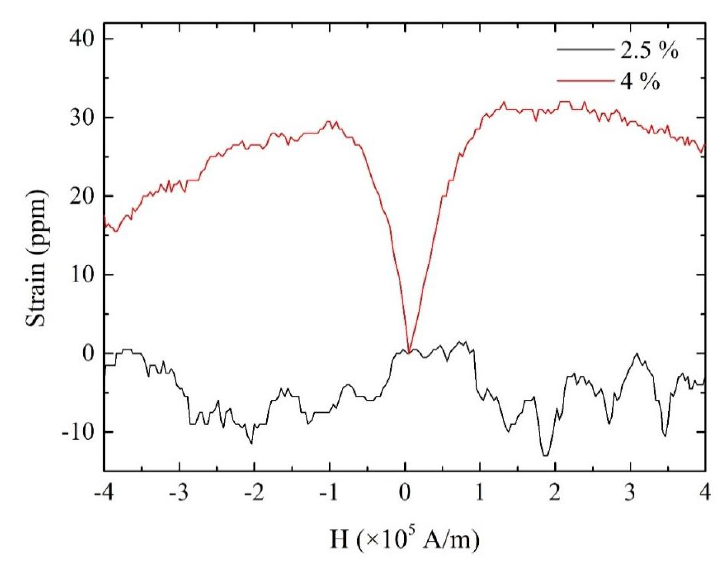
Figure 6. Strain versus external magnetic field of the discontinuous Fe-Co fiber / epoxy composite sheets.